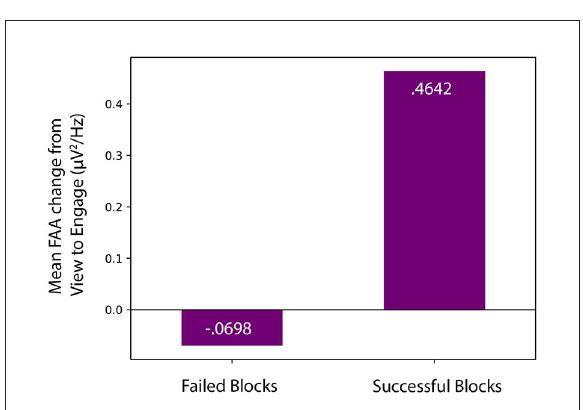
FIGURE9 Mean FAA change from View to Engage for both successful and unsuccessful